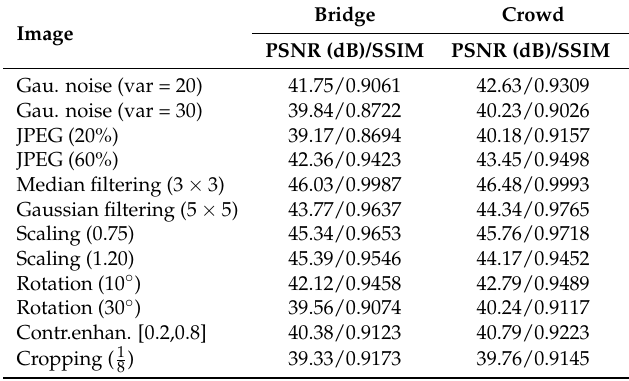
Table 2. Performance results of the Bridge and Crowd images against common